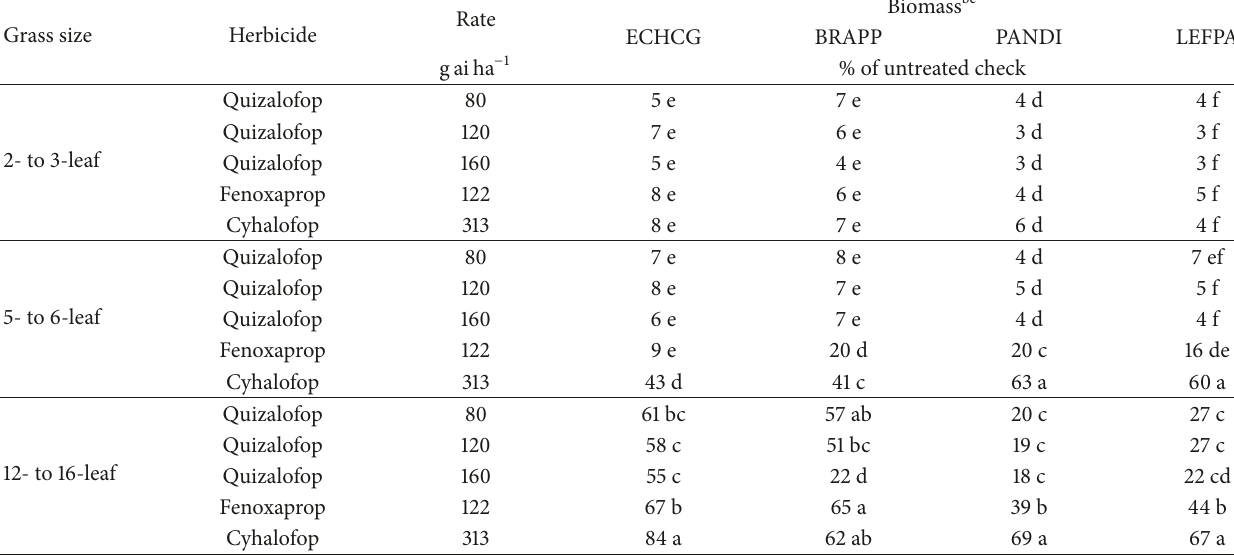
Table 2: Effect of ACCase-inhibiting herbicide and growth stage at time of application on relative biomass of barnyardgrass, broadleaf signalgrass, fall panicum, and Amazon sprangletop at 21 DAT. a Biomass bc Rate Grass size Herbicide ECHCG BRAPP PANDI LEFPA gaiha −1 % of untreated check Quizalofop 2- to 3-leaf